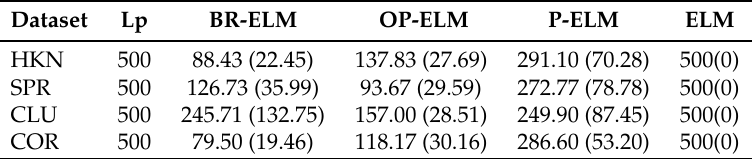
Table 3. Number of neurons selected in the